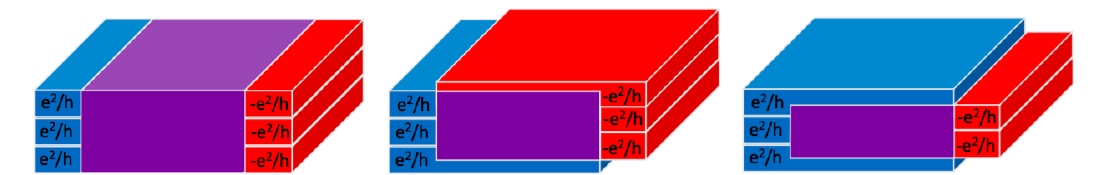
Figure 8: Cartoon model of conventional insulator and axion insulators built from overlapping Chern insulators. The ends of the diagrams are supposed to described some fictitious regions where the Chern layers are exposed. It is not supposed to represent a real system (although it could). (left) Chern insulators or quantum Hall 2 2 layers of e and − e are centered on top of each other in a conventional insulator h h giving no net Hall response at any surface. Regions where Chern layers overlap are given in purple. (center) The distributions of layers in a topological insulator such e 2 e 2 that − 1 and + 1 are left on the surfaces giving the half-quantized Hall response 2 2 h h of a surface and the quantized mangetoelectric effect. An applied electric (magnetic) field will give a magnetization (polarization) pointing in the same direction. Such a scenario would be realized if the surface magnetization was everywhere pointed outwards, or if a TI slab was placed in magnetic field, but the top and bottom surfaces were differentially doped to be electron and hole-like. (right) Here the topmost − e e 2 layer has be removed such that + 1 is left over on the top surface. One can see 2 h that the bulk is not effected. A scenario as such is effectively realized in a TI slab in magnetic